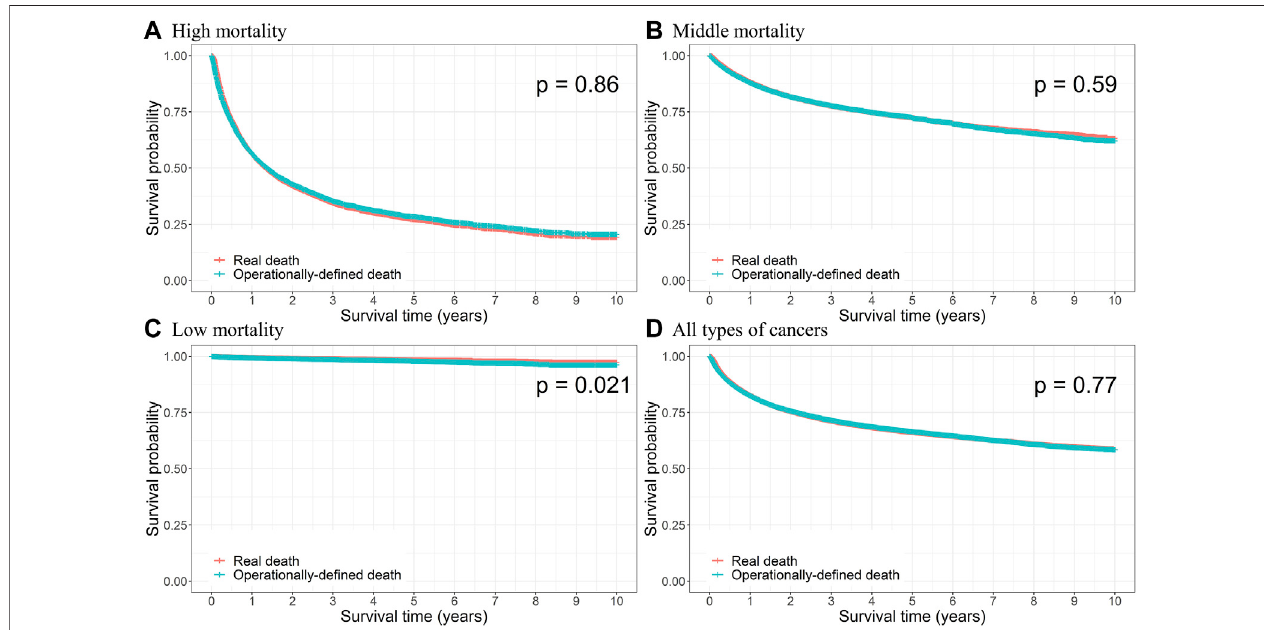
FIGURE2| Kaplan – Meiercurvesoftherealandoperationalde fi nitionofdeath(ODD)andlog-rank test p -valuefor (A) high, (B) middle, and (C) lowmortalities,and (D) all types of cancers.